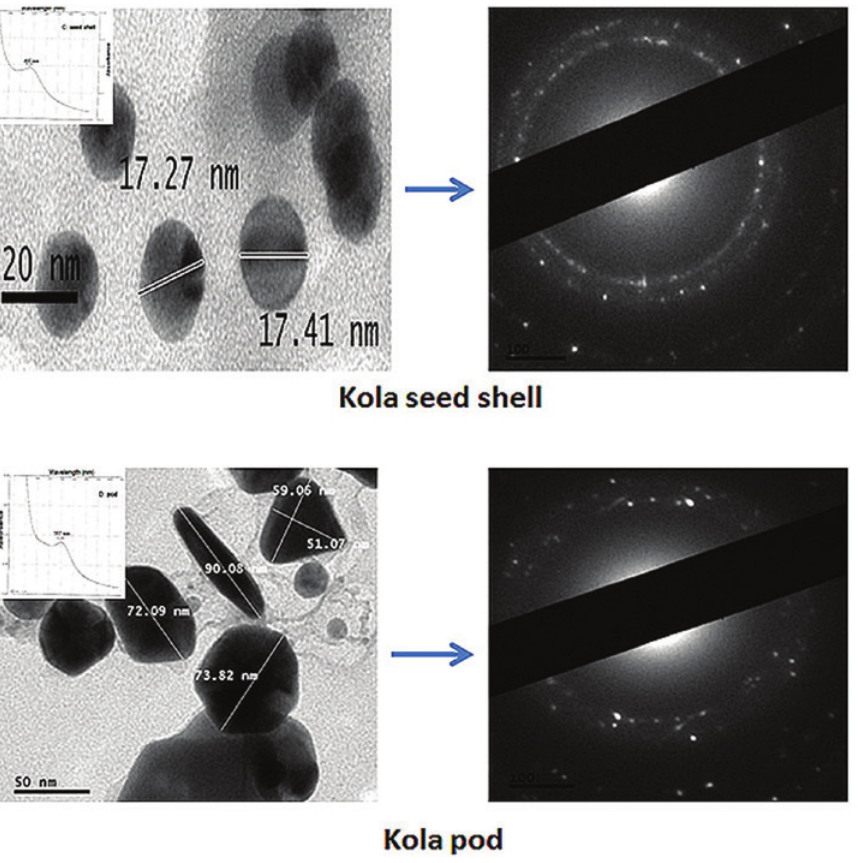
Figure 6: TEM images of biosynthesized Ag-AuNPs using some important agro-wastes (inset, UV-Vis absorption